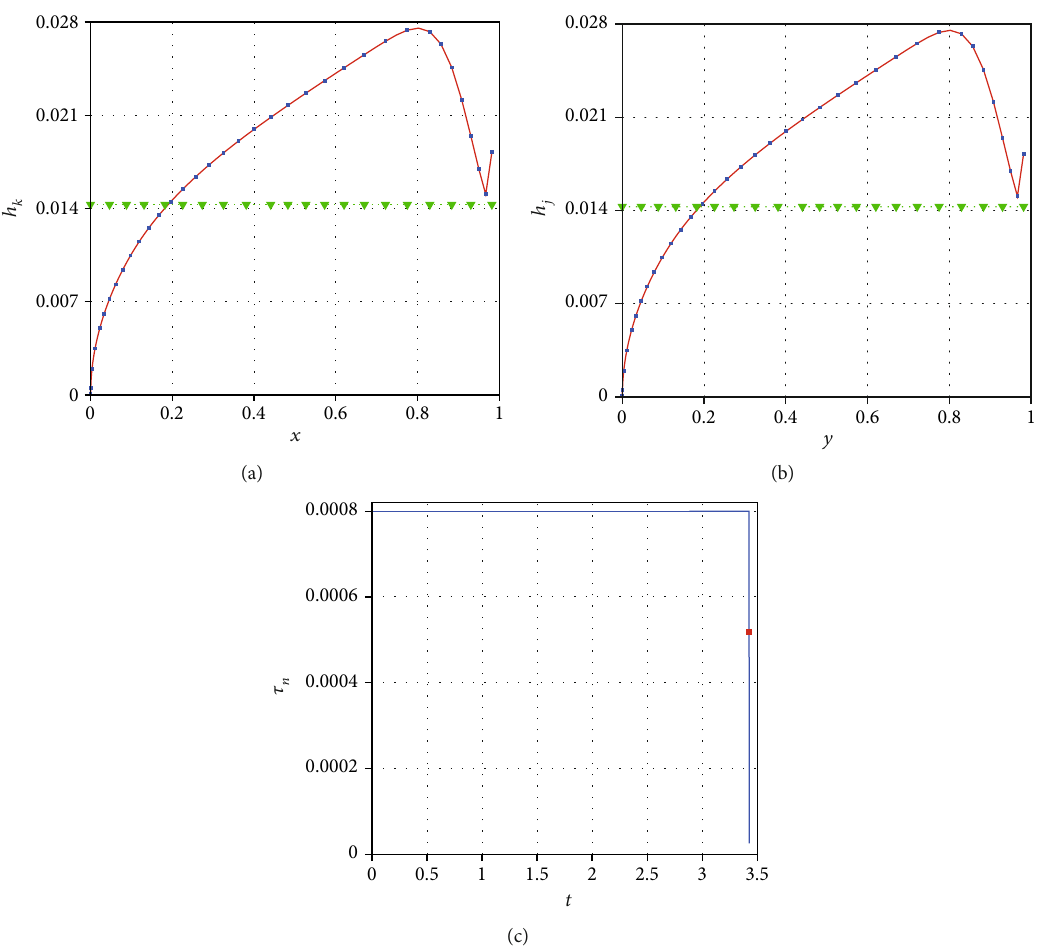
x processes; (b) the variation of spatial step h k as = b = 3, α = β = 15 based on convection term b / ð 1 + α x + β y Þ x y